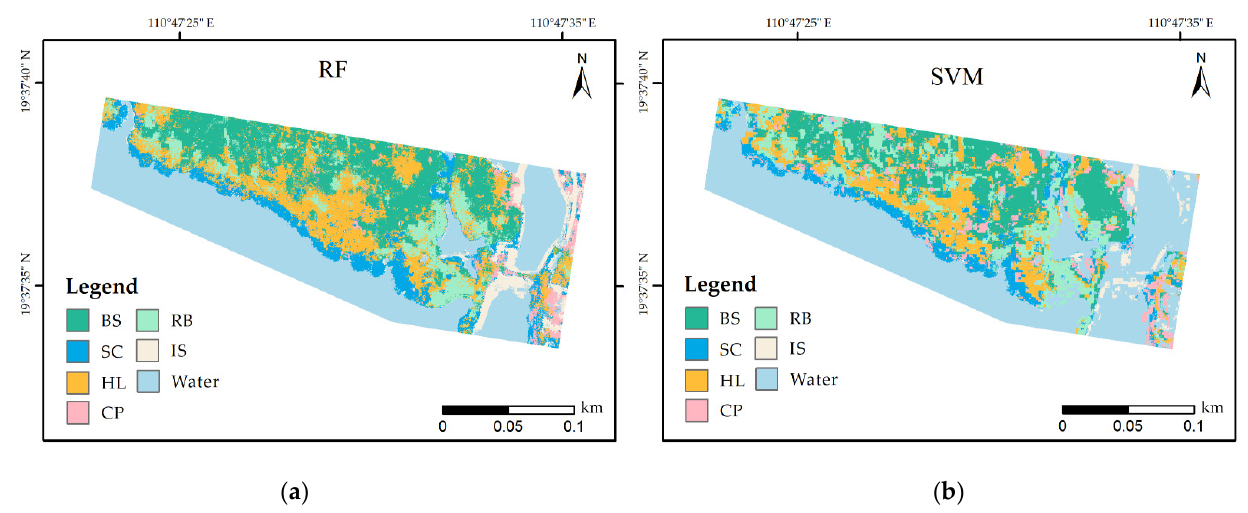
Figure 8. Mangrove mapping in the study area with UAV hyperspectral images and WV-2 images based on: ( a ) RF model and ( b ) SVM model.